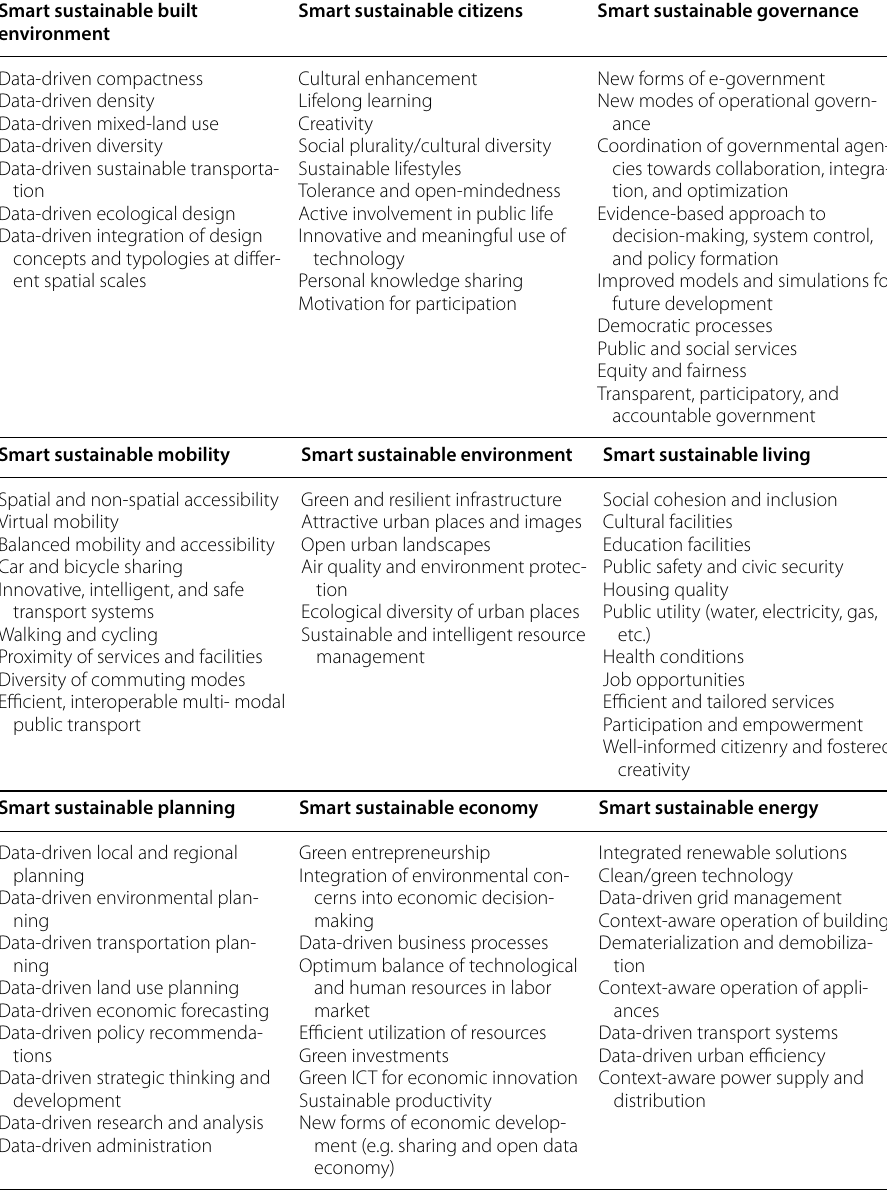
Smart sustainable citizens